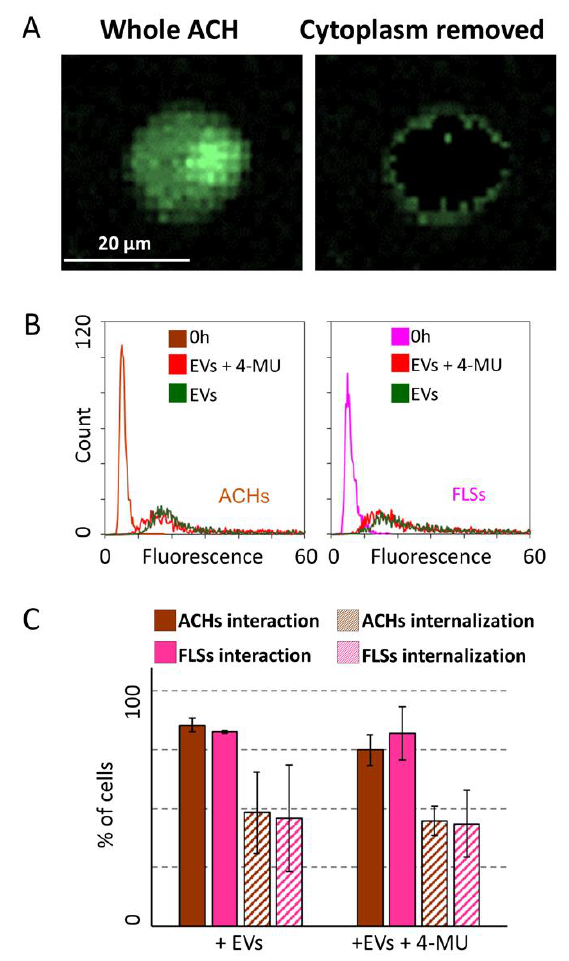
Figure 7. HA removal e ff ect on ASC-EV interaction with and incorporation in ACHs and FLSs in 3D microfluidic devices. ( A ) Image of a selected ACHs before and after removal of fluorescence signals associated with the cytoplasm. The presence of EVs outside the cell body is clear. ( B ) EV fluorescence intensity at time 0 and 24 h of ACHs and FLSs treated or not with 4-MU inside the 3D microfluidic device. 4-MU treated samples at time 0 are not shown for clarity, since no di ff erences with control samples at time 0 emerged. N = 3 ( C ) ASC-EVs interacting with or internalized in ACHs or FLSs with or without treatment with 4-MU at 24 h. N = 3, values are shown as mean ± SE. Significance for p -value < 0.05.